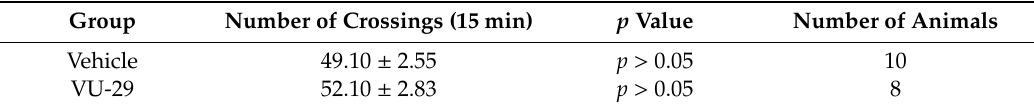
Table 4. The e ff ect of VU-29 administration on locomotor activity as measured as the number of crossings from one compartment to another during 15 min of Test 2. Results are expressed as mean ± SEM.